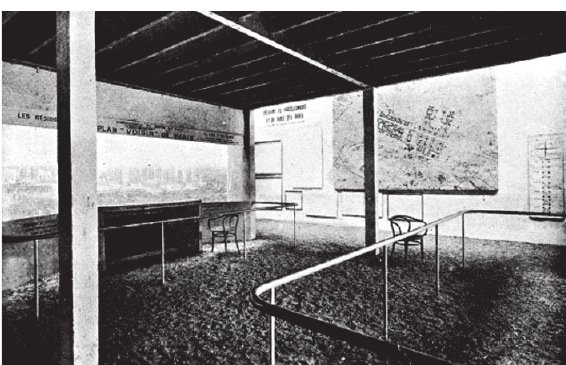
fig. 5. Exposé au Pavilion de l’ESPrIT nouVEau à l’Exposition Internationale des arts